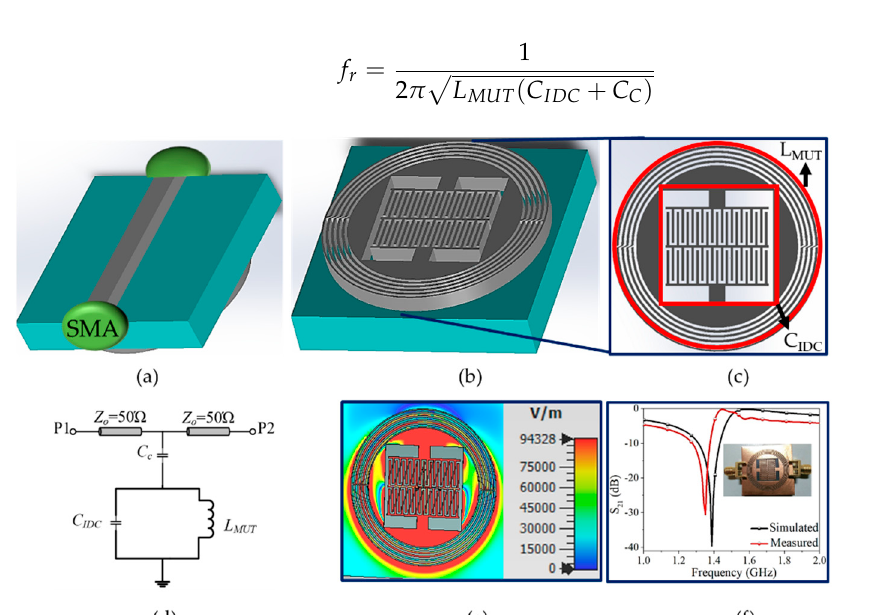
Figure 1. The 3D geometry of the proposed non-contact optimized microwave sensor layout: ( a ) front side of the proposed design; ( b ) backside of the proposed design; ( c ) simulation-based bridge-type structure; ( d ) equivalent circuit of the designed sensor; ( e ) strength of high intensity coupled e-field revealing a maximum field at the center of the developed sensor; and ( f ) comparison of the resonating frequency of simulated and measured prototype for unloaded MUTs.